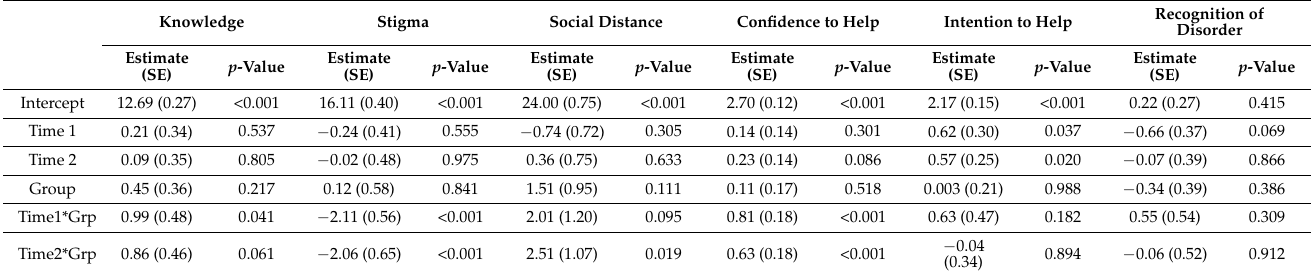
Table 4. Generalized Estimating Equations (GEE) to assess the effects of time, group and